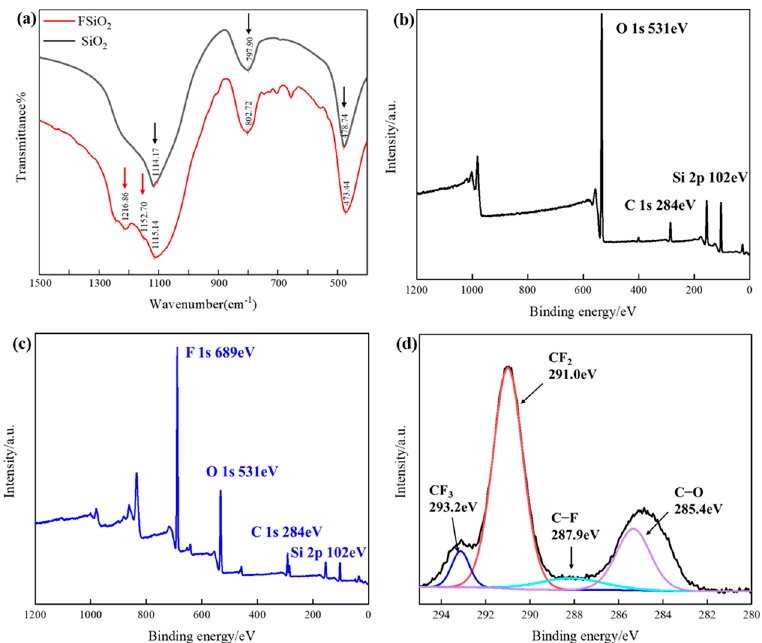
Figure 2. FTIR and XPS characterization of SiO 2 before and after fluoridation. ( a ) FTIR. ( b ) XPS of SiO 2 . ( c ) XPS of FSiO 2 . ( d ) The peak-splitting result of element C. Table 1. Proportion of elements on SiO 2 surface before and after